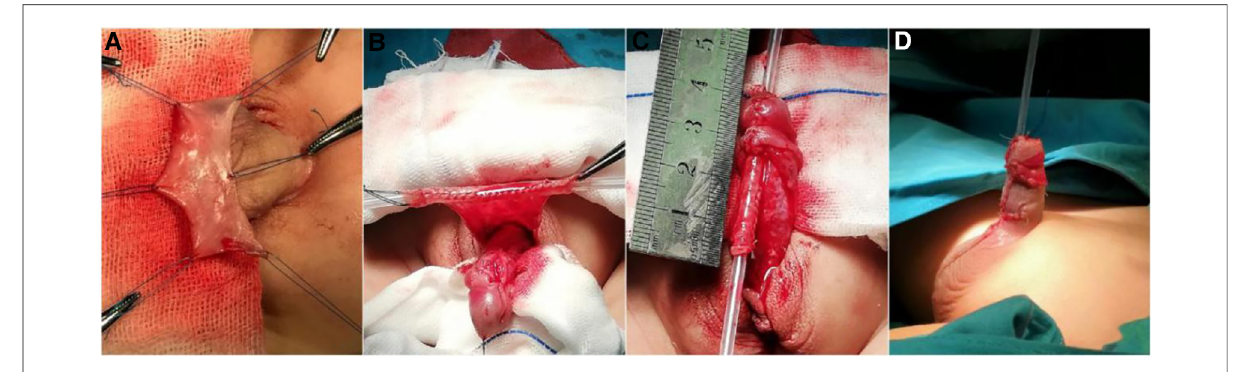
FIGURE 1 Surgical procedure of TPIFU (the Duckett ’ s procedure). ( A ) Separate the dorsal skin fl aps. ( B ) Clip the rectangular fl ap from the inner prepuce, and roll the mobilized foreskin into a tube over a catheter. ( C ) Transpose the tubulate urethra ventrally through the glans channel and anastomose with the native urethra. ( D ) Postoperative appearance. TPIFU, transverse preputial island fl ap